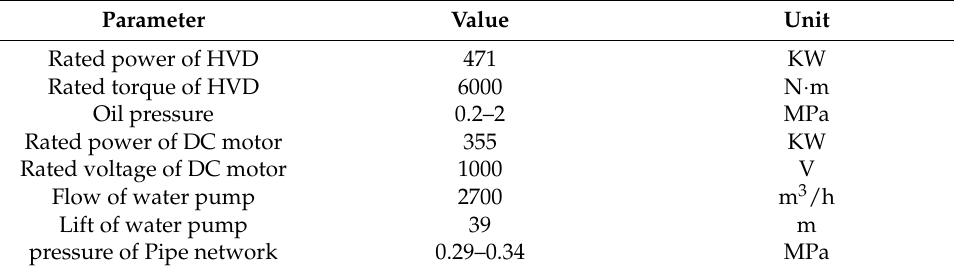
Table 1. Original technical parameters of water supply